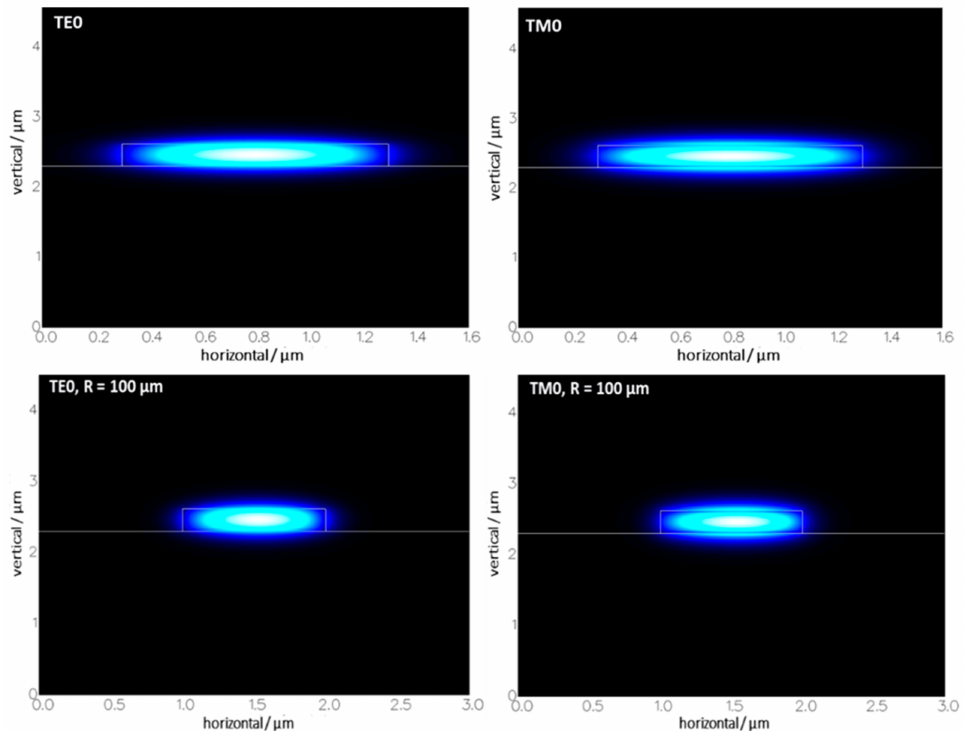
Figure 2. Cross-sections of fundamental modes for straight ( up ) and bend WGs ( down